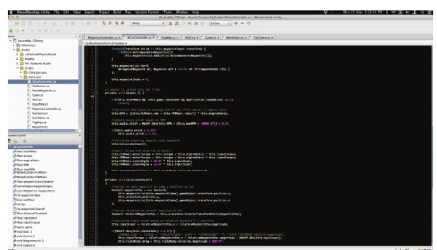
Figure 5: The start screen of Racer.